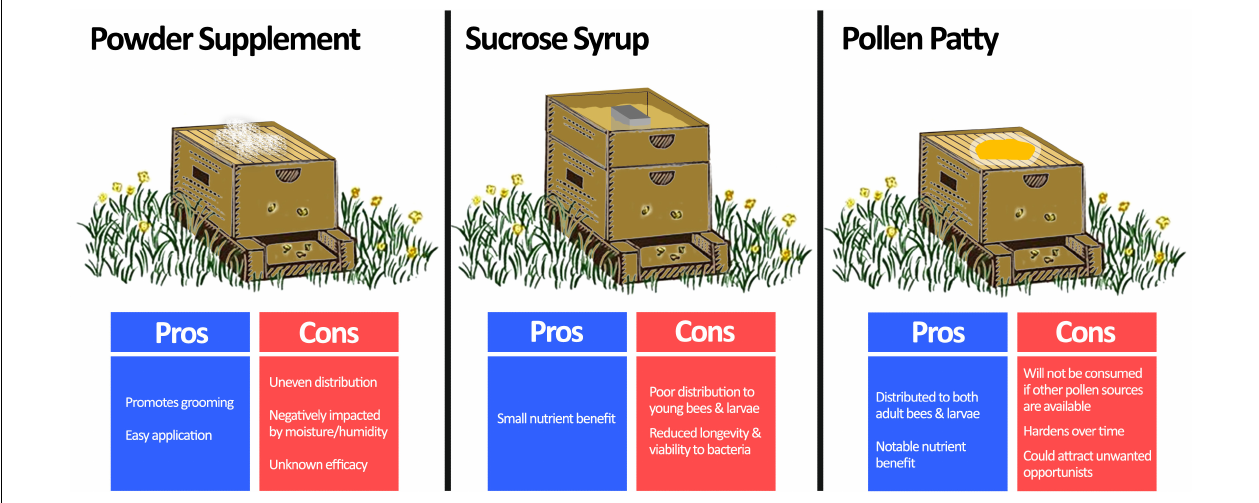
FIGURE 4 | Comparison of methods for beneficial bacteria supplementation. Beneficial bacteria are usually combined with a vehicle to supplement honey bees in one of three ways: powder supplementation, sucrose syrup, or pollen patty. Powder supplementation can be easily performed by spreading a probiotic infused dust on the beehive, which also promotes bees to groom. However, it is prone to uneven distribution, negative impacts of moisture, and unknown efficacy as an application method. Sucrose syrup supplementation can be achieved by adding probiotics directly to conventional sucrose feeders for the hive. Although this method benefits from a small nutrient enhancement, the sucrose solution is not usually distributed well to all members of the hive, and it is an unfavourable environment for the bacteria. Pollen patty supplementation involves adding beneficial bacteria directly to a traditional pollen supplement. In addition to the added nutrient benefit, pollen patty supplementation will be distributed throughout the hive to both adult bees and larvae. However, if sufficient nutrient sources already exist, then the pollen patty may be disregarded by the hive. Moreover, it is prone to hardening over time and could attract unwanted pests. Langstroth beehive image modified from Net Art under the Creative Commons Attribution 2.0 Generic License